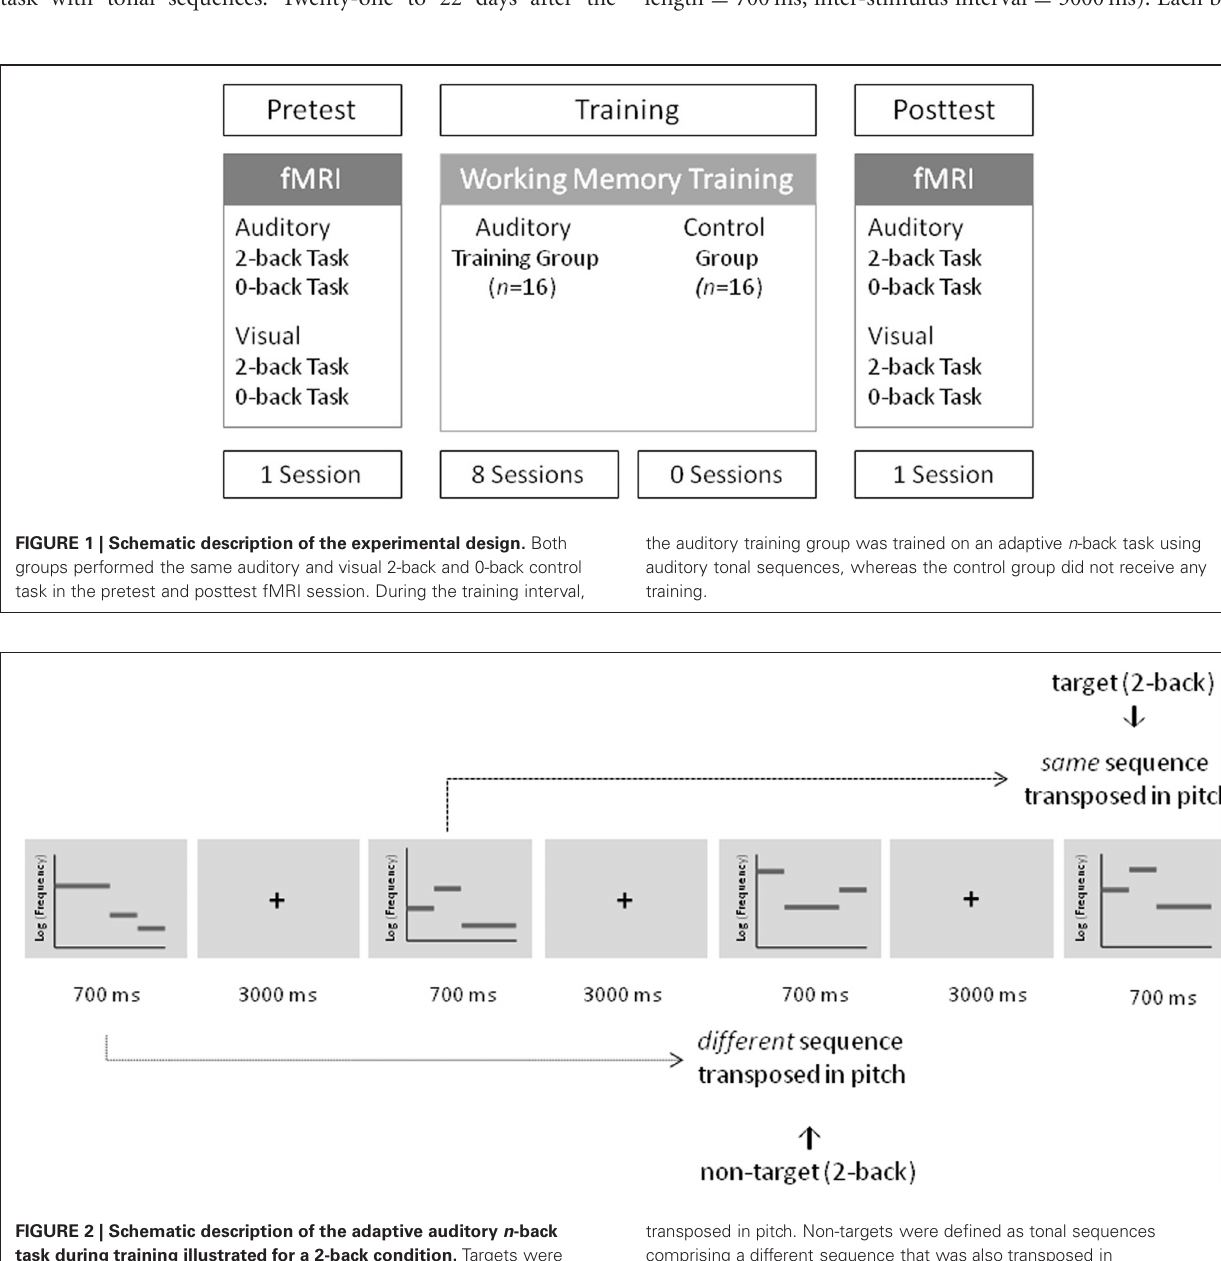
transposed in pitch. Non-targets were defined as tonal sequences comprising a different sequence that was also